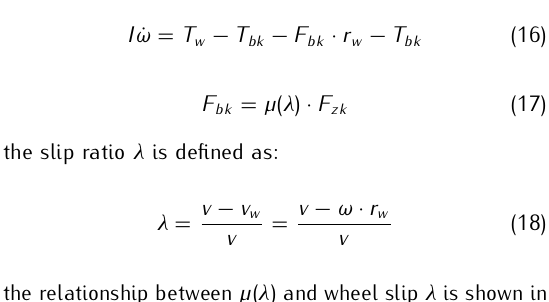
Figure 5. (a) wheel-road model; (b) the relationship between friction coefficient and wheel slip.